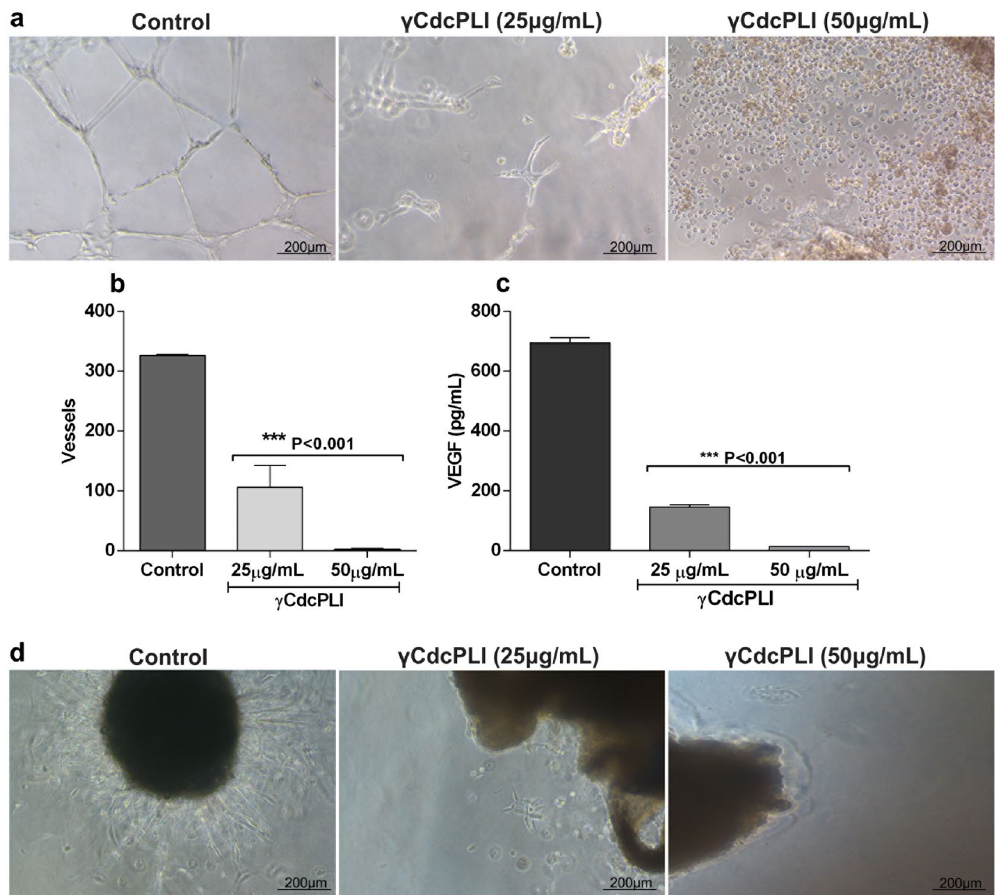
Figure 6. Analysis of in vitro and ex vivo angiogenesis assay. ( a) Vessel formation of HUVEC cells when treated with RPMI medium and γ CdcPLI at 25 μ g/mL for 18 hours. ( b) Representative quantification of number of vessels formed ( c) VEGF quantification in HUVEC cell supernatants. ( d) Sprouting of elongated vessels from the ex vivo aortic ring model when treated with medium (control) and γ CdcPLI at 25 and 50 μ g/mL for 7 days. All data are expressed as mean ± S.E.M and all experiments were carried out in triplicate; differences between treatments and controls were analyzed by Unpaired t-test. Statistically significant: ** p < 0.05 and *** p <